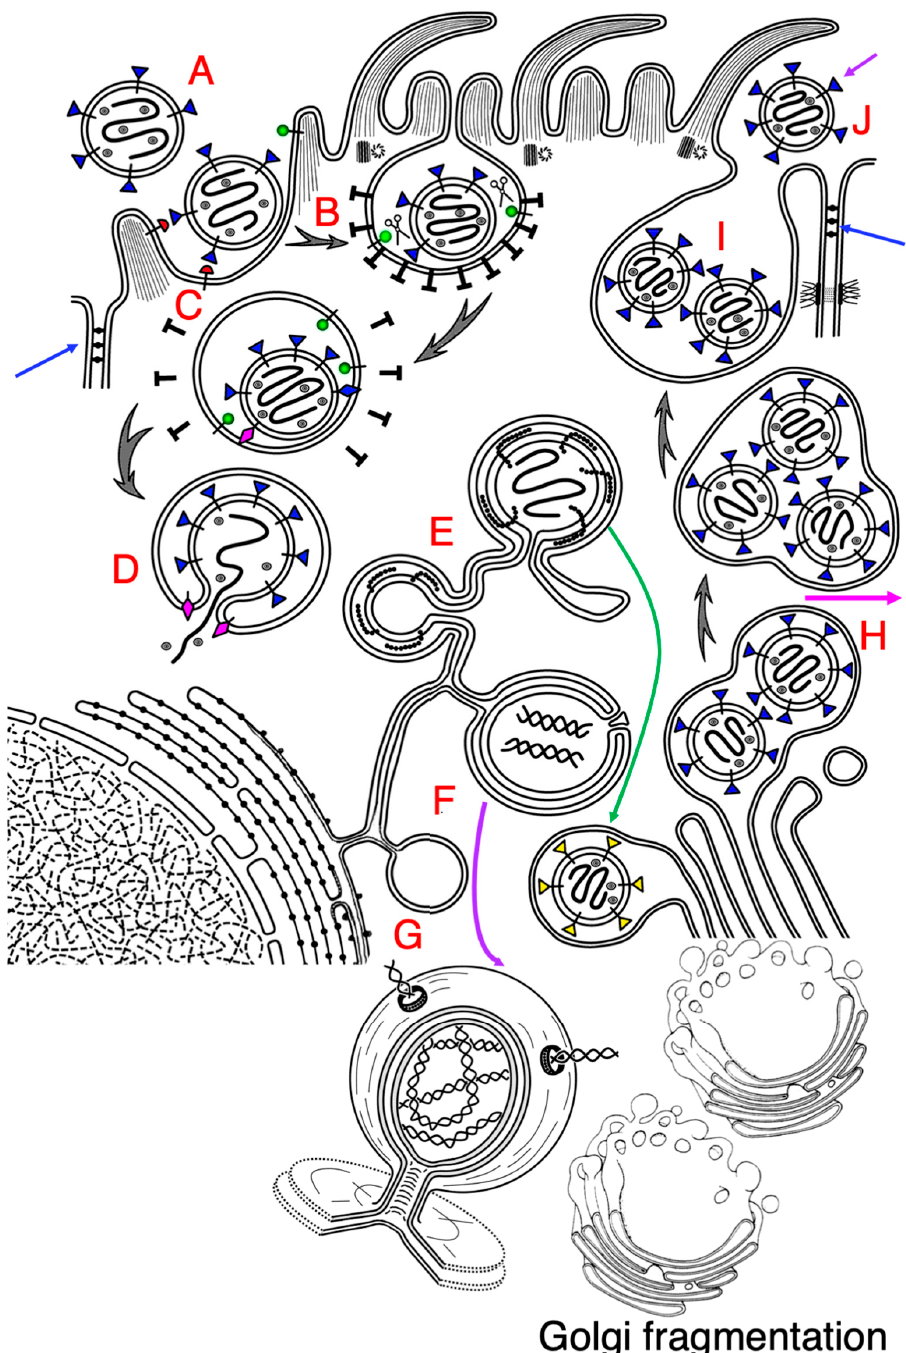
Figure 1. Biogenesis of SARS-CoV-2. The scheme shows interactions of SARS-CoV-2 with an epithelial ciliated cell. ( A ) After attachment of the virion to ACE2 (transmembrane structure with a hemi- spherical red head). ( B ) Clathrin-dependent endocytosis indices invagination of the apical plasma membrane and formation of endosome ( C ). Then, S-protein of SARS-CoV-2 (transmembrane struc- tures with the triangle blue heads) is subjected to cleavage with TMDRSS2 (transmembrane structure with a spherical green head). It (magenta rhomb) perforates the endosomal limiting membranes ( D ). RNA of SARS-CoV-2 enters the cytosol ( D ) and forms the zippered endoplasmic reticulum ( E ). Simultaneously, double membrane vacuoles (DMV; ( F , G )) are formed. ( G ) DMVs are filled with dsRNA and contain pores, through which dsRNA can move. Budding of the virus occurs within the ER exit site and ZER ( E ). During budding, the S-protein appears to be not fully glycosylated. After their budding, the viral particles are delivered to the Golgi complex and transported through it